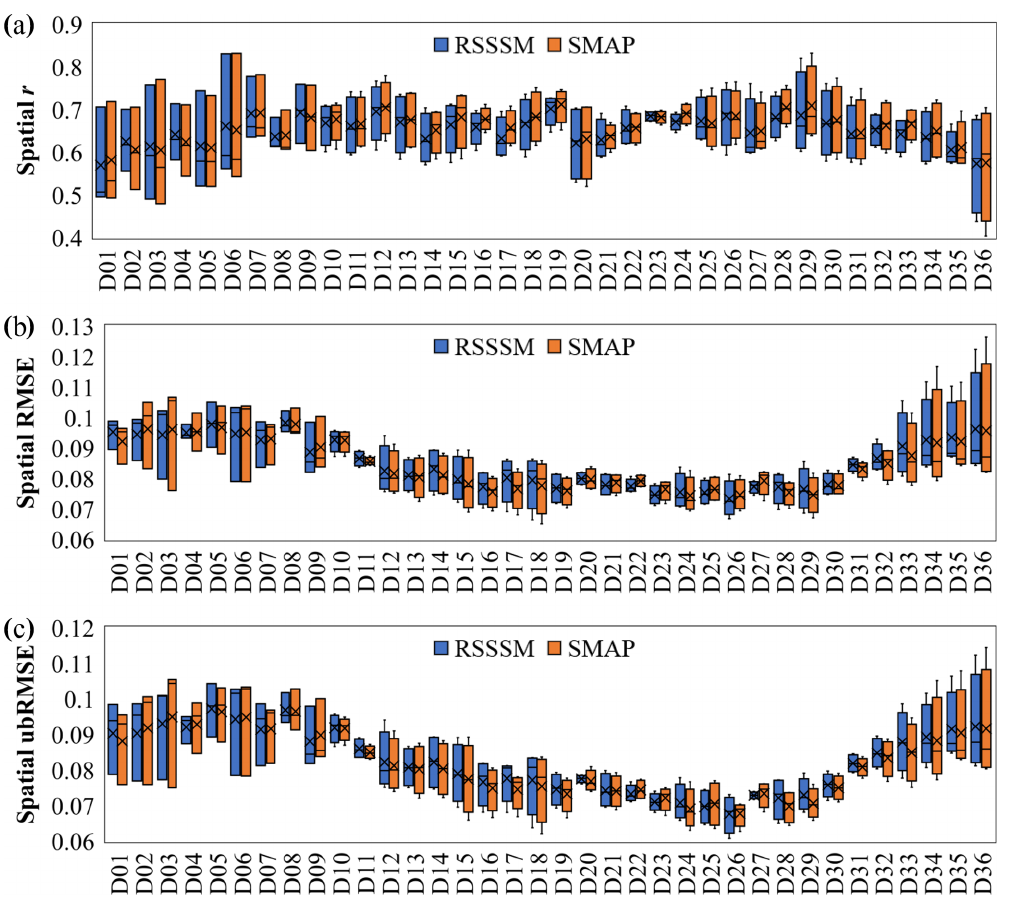
Figure 6. Comparison of the spatial-pattern accuracy between RSSSM and SMAP in different 10d periods from April 2015 to 2018. The three evaluation indexes are (a) r , (b) RMSE, and (c) ubRMSE. The lengths of boxes and error bars are determined from the evaluation index values in 3 (January to March) or 4 (April to December)